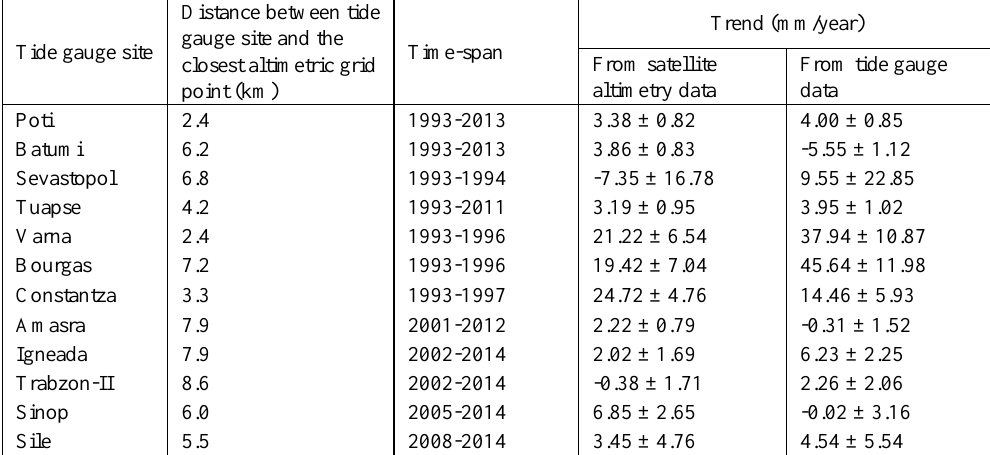
Table 2. Trend of sea level changes at tide gauge sites from satellite altimetry and tide gauge data in common observation